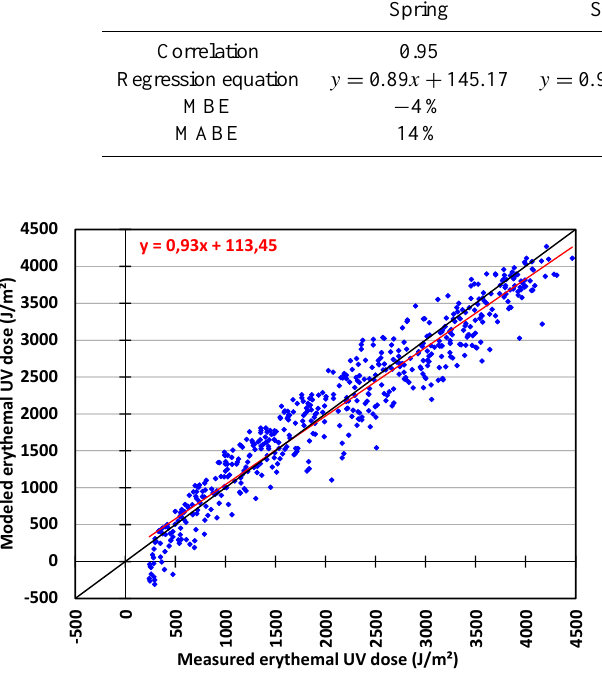
Figure 8. Validation of the multiple linear regression equation: the Figure 7. Scatterplot of the measured and modeled erythemal UV upper panel shows the measured (in blue) and modeled (in red) ery- Fig. 8. Validation of the multiple linear regression equation: the upper panel shows the mea- doses at Uccle for the 2009–2013 validation period. The red line Scatterplot of the measured and modeled erythemal UV doses at Uccle for the Fig. 7. themal UV values; the lower panel presents the absolute sured (in blue) and modeled (in red) erythemal UV values; the lower panel presents the abso- represents the regression line of the data ( f (x) = 0 . 93 x + 113 . 45). 2009-2013 validation period. The red line represents the regression line of the data lute residuals. The black line is the f (x) = x line. (f(x)=0.93x+113.45). The black line is the f(x)=x line.